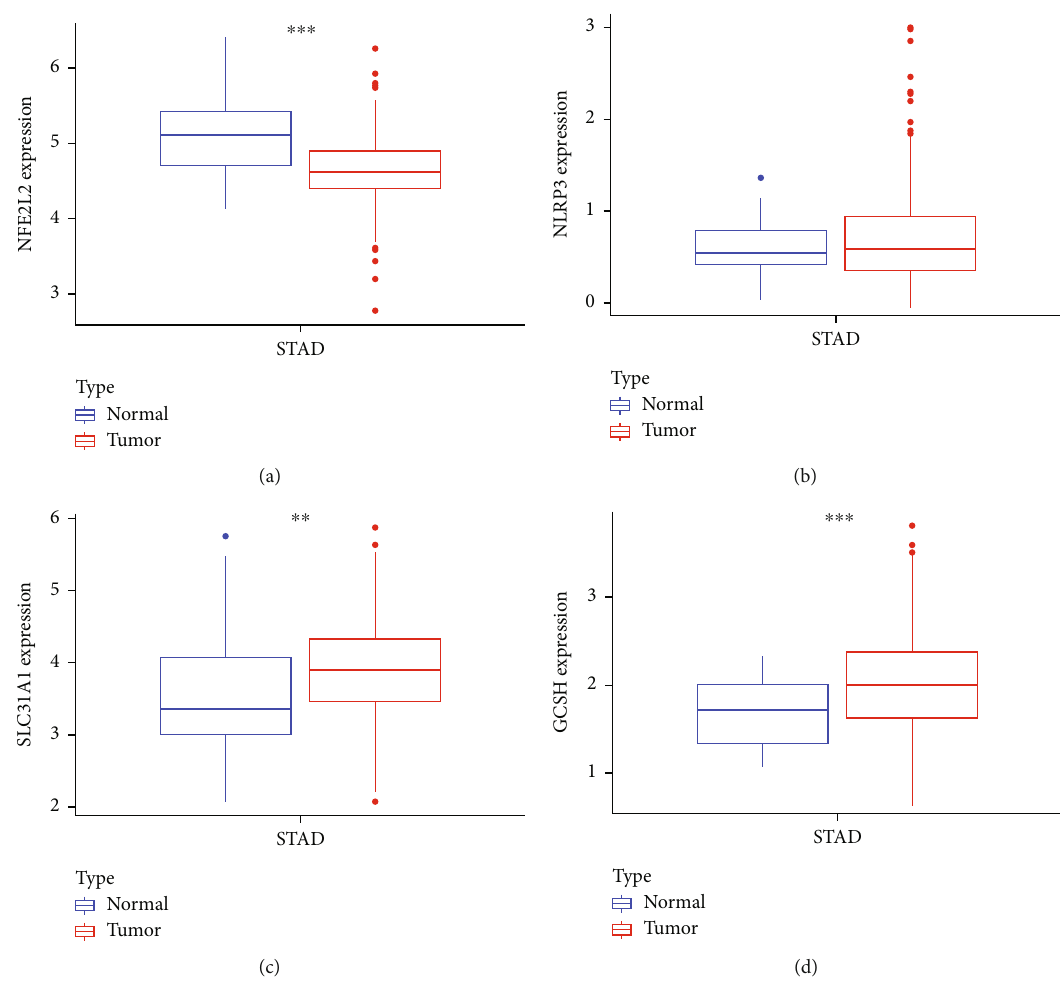
Figure 8: Relative expression of core target genes. (a) Relative expression of NFE2L2. (b) Relative expression of NLRP3. (c) Relative expression of SLC31A1. (d) Relative expression of